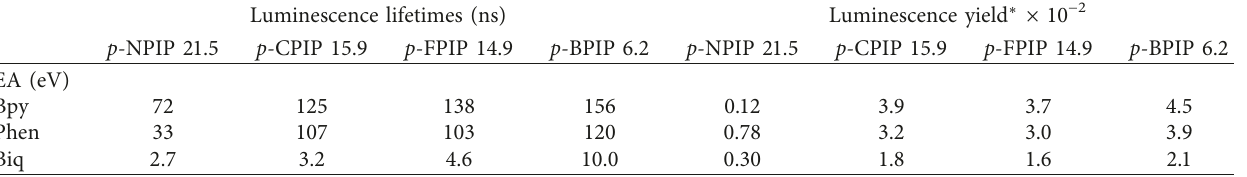
Table 3: Luminescence data for ruthenium complexes aerated in acetonitrile.